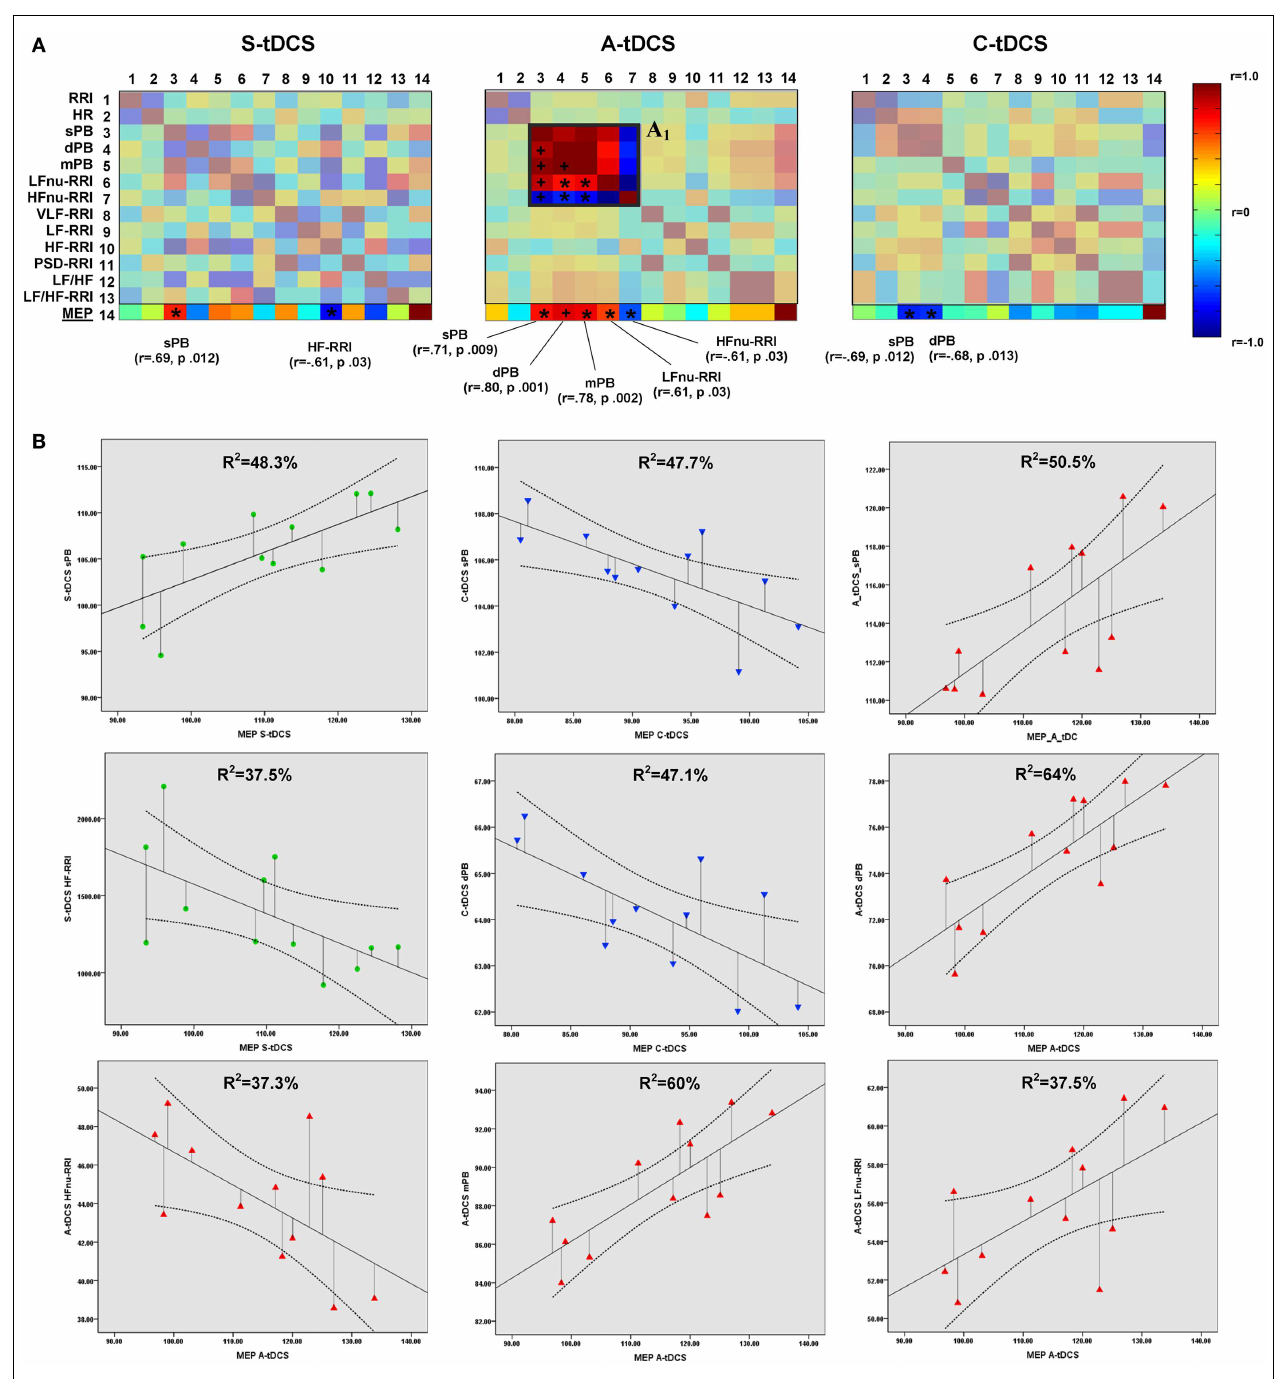
correlation. Insert A 1 highlights the increased positive correlation between systolic (sBP), diastolic (dBP), mean blood pressure (mBP), and LFnu-RRI values during anodal stimulation, and the negative correlation between these values and HFnu-RRI ( * p < 0.05; + p < 0.01). Significant values entered a further linear regression analysis, whose results are shown in (B) . A linear fit line with confidence intervals and the amount of variance in vital parameters explained by MEP values ( R 2 ) are